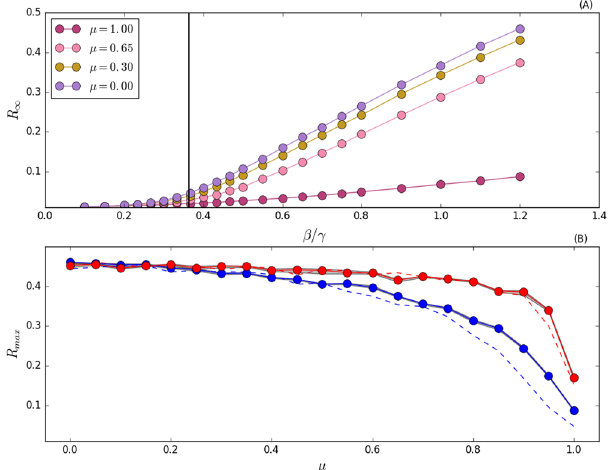
Figure 4. Panel (A) R ∞ as a function of β / γ , for selected values of μ and s min = 10. Vertical black line represents the theoretical value of the epidemic threshold for μ = 0 as derived in refs 24,71 . Panel (B) R max , i.e. the max value of R ∞ , as a function of μ . In red curves we set s min = 100, in blue curves s min = 10. In solid curves, we draw community sizes directly from the community size distribution P ( s ). In dashed curves, we fix the community sizes as equal to the average value of P ( s ) for all communities. The 95% confidence interval is in grey. Each point is an average of 10 2 independent simulations.